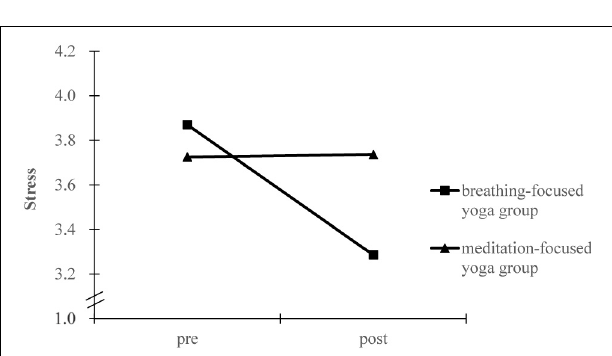
FIGURE 3 | Marginal means estimated for stress before and after intervention by